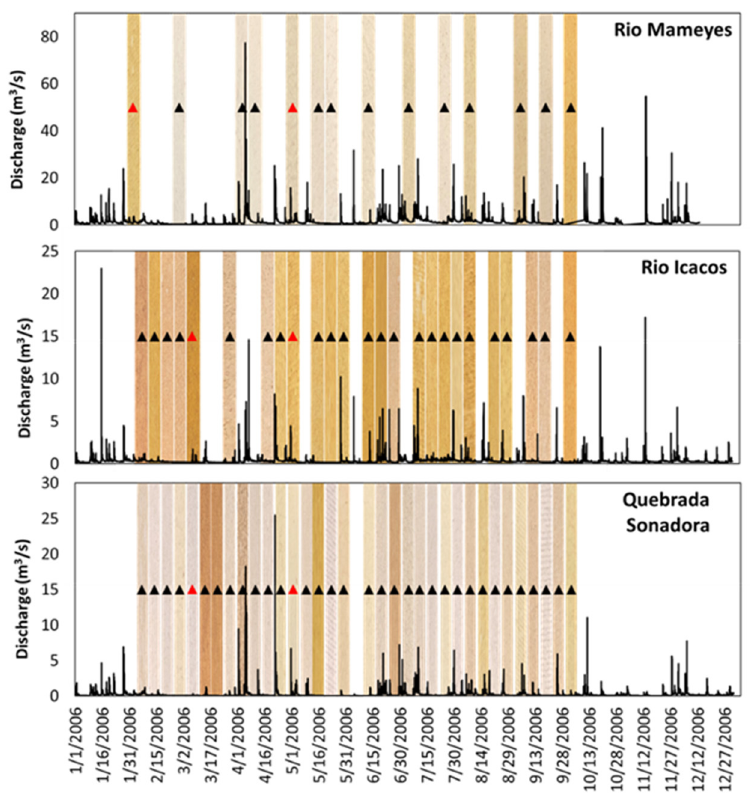
Figure 2. River hydrographs overlain on cropped images of collected filters (vertical yellow-brown bars) for respective river and sampling date. Black triangles represent a date of sample collection, and red triangles indicates sample has been analyzed with SEM-EDS (date format: MM/DD/YYYY).